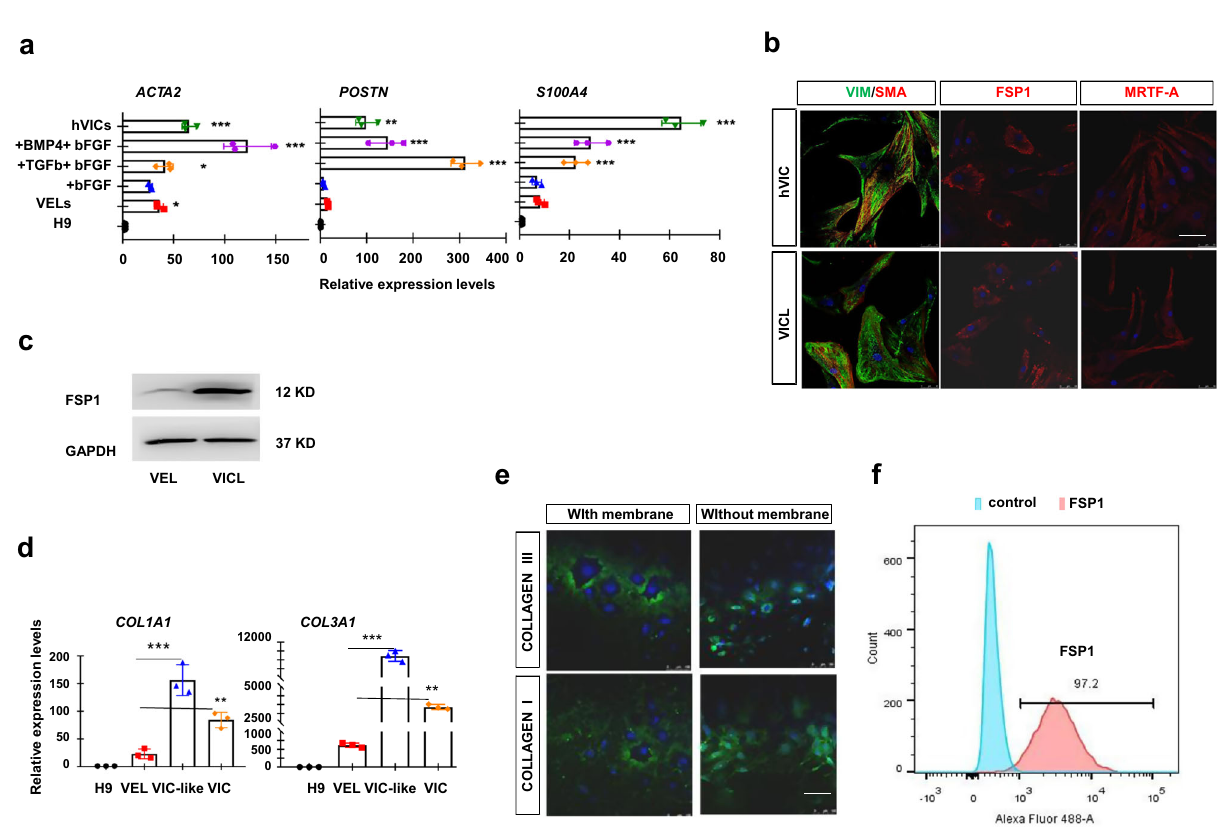
Fig. 7 HPSC-derived VELs to VIC-like (VICL) cells by inducing EndoMT. a The qPCR analysis of indicated VIC markers for hPSC-derived VELs that were treated with the indicated signaling molecules for 3 – 6 days. b IF staining of hPSC-derived VIC-like (VICL) cells showing the expression of the indicated VIC markers. The primary VICs were used as positive controls. Scale bar: 100 μ m. c WB analysis showing the expression levels of FSP1 in hPSC-derived VEC- like cells and VICL cells. d The qRT-PCR analysis of type I collagen marker COL1A1 and type III collagen marker COL3A1 in hPSC-derived VIC-like cells. The primary VICs were used as positive controls. e IF staining showing the expression levels of COLLAGEN I and III in hPSC-derived VIC-like cells, with and without membrane breaking treatment. f Flow cytometry analysis showing the percentage of FSP1 positive cells in hPSC-derived VIC-like cells. All experiments were repeated three times. The paired t test in Graphpad software was used for the statistical analysis. Signi fi cant levels are: * p < 0.05; ** P < 0.01; *** P < 0.001. Shown are representative images in ( b , c , e